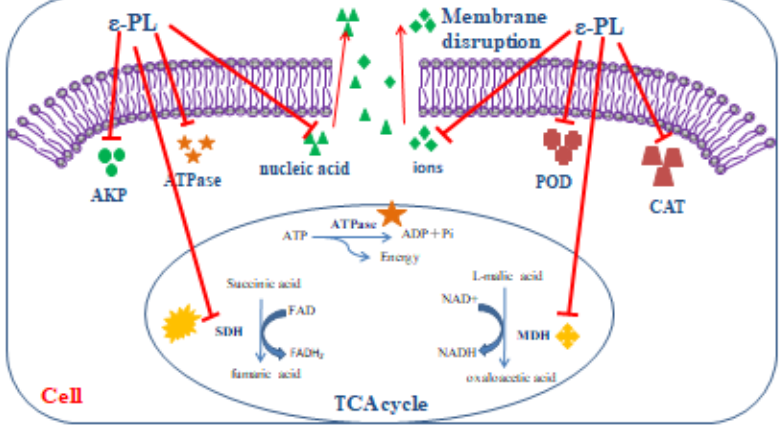
Figure 9. Schematic representation of the possible inhibitory mechanisms of ε-PL against S. putrefaciens.